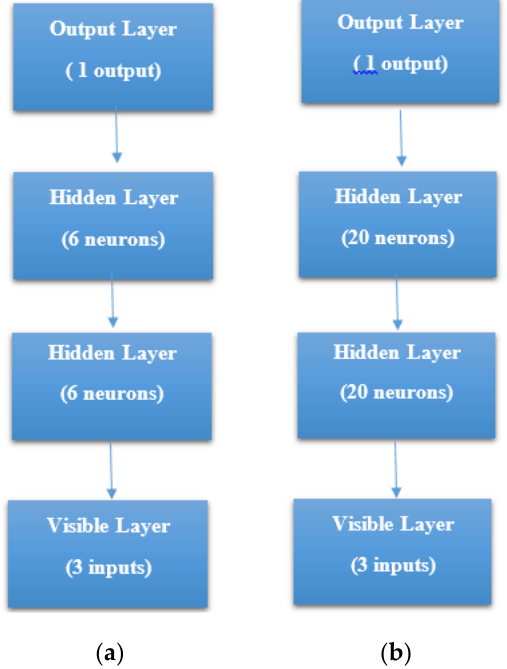
Figure 7. ( a ) The Architectural Structure of the ANN model (3-6-6-1); ( b ) The Architectural Structure of the ANN model (3-20-20-1).